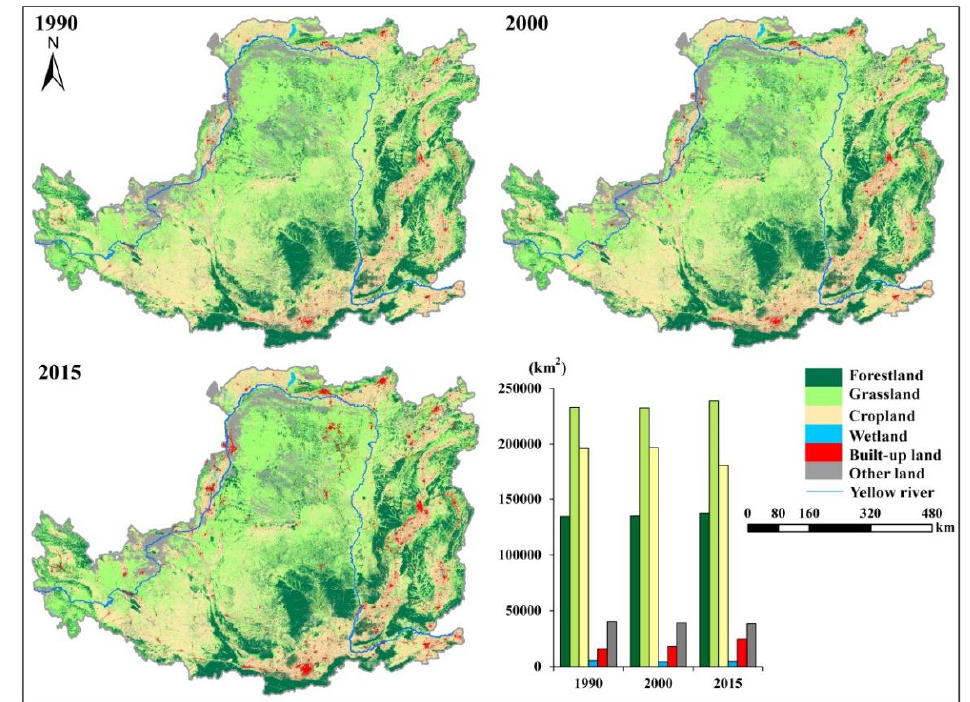
Figure 3. Land-use / land-cover patterns of Loess Plateau in 1990, 2000 and Figure 3. Land-use/land-cover patterns of Loess Plateau in 1990, 2000 and 2015.